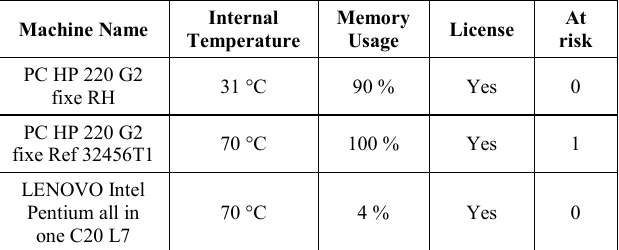
S AMPLE OF THE M ONITORING D ATA I MPORTED FROM M ONITORING S